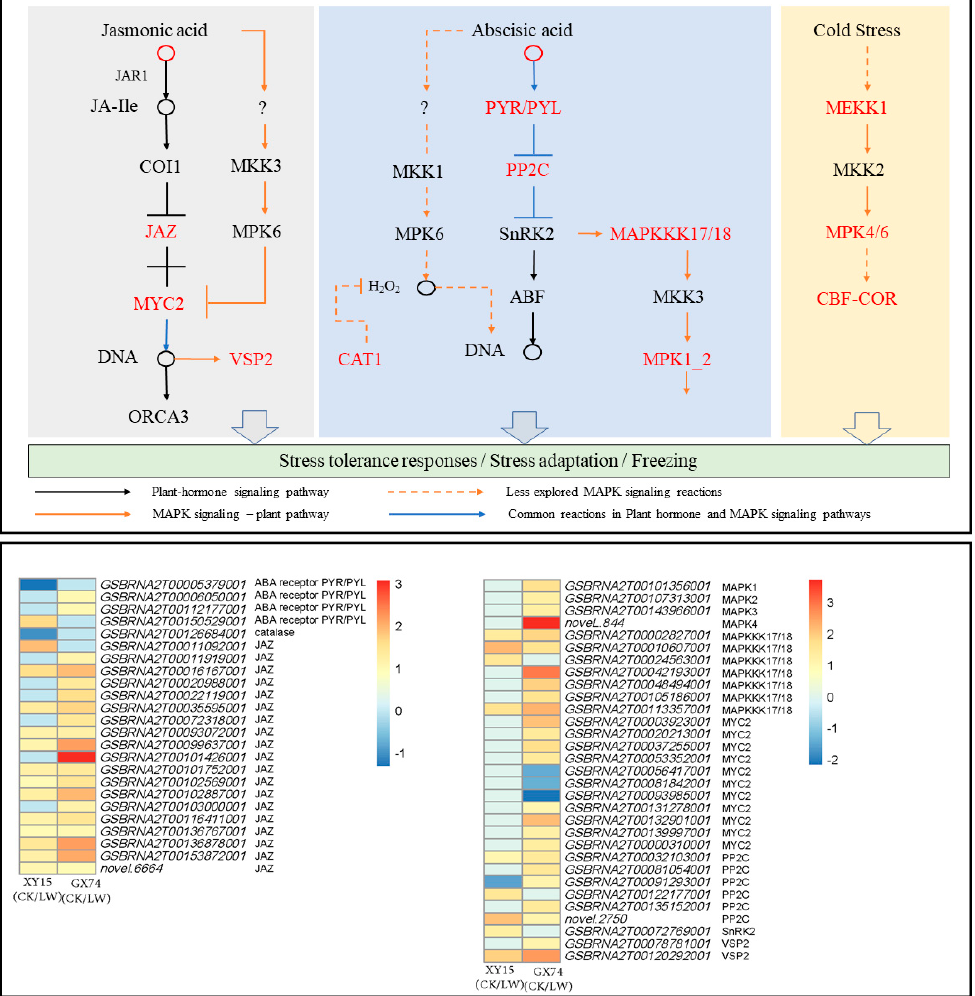
Figure 7. Expression changes in plant-hormone signaling and MAPK signaling—plant pathways in XY15 (cold-sensitive) and GX74 (cold-tolerant) rapeseed siliques—in response to cold treatment. The pathways are drawn according to the respective reference pathways in KEGG pathway database [25]. The heatmap was drawn in TBtools [27] using the log2 foldchange values of differentially expressed genes enriched in these two pathways. CK and LW represent control and cold treatments. The gene abbreviations and other genes refer to full names presented in Table S5.